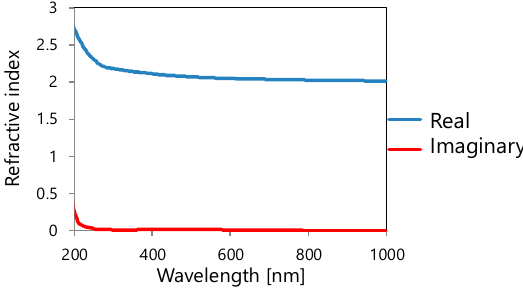
Figure 3. Refractive index of HfO 2 used for calculation.